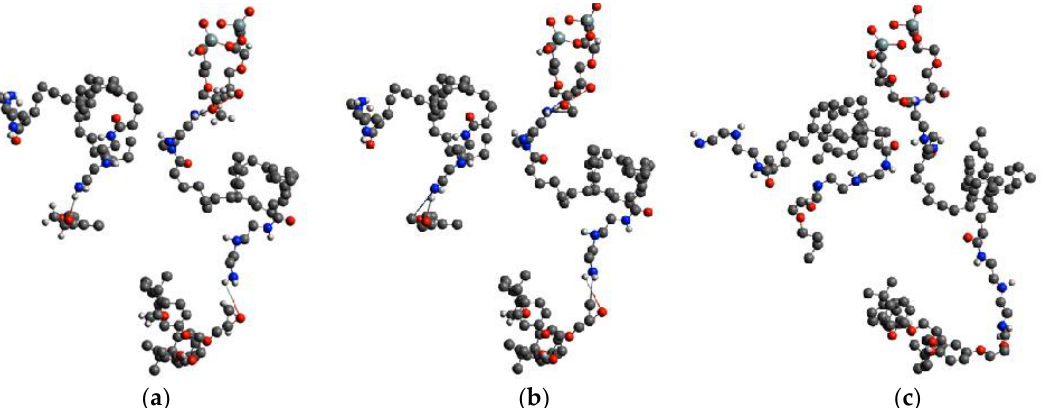
Figure 2. Simulation snapshots showing ( a ) crosslinking reaction between O (red) and H (white) atoms to from new O-H bond and ( b ) between C (grey) and N (blue) to form a new C-N bond, while amine N-H bond and epoxy C-O bonds are broken, and ( c ) the re-equilibrated system.